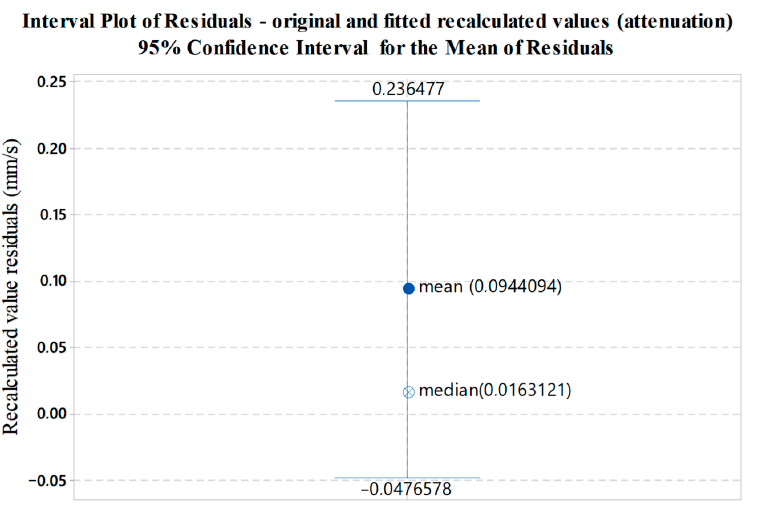
Figure 14. Graphical display of the variability of residuals (errors) between the measured and fitted recalculated values with respect to data shown in Figure 11.